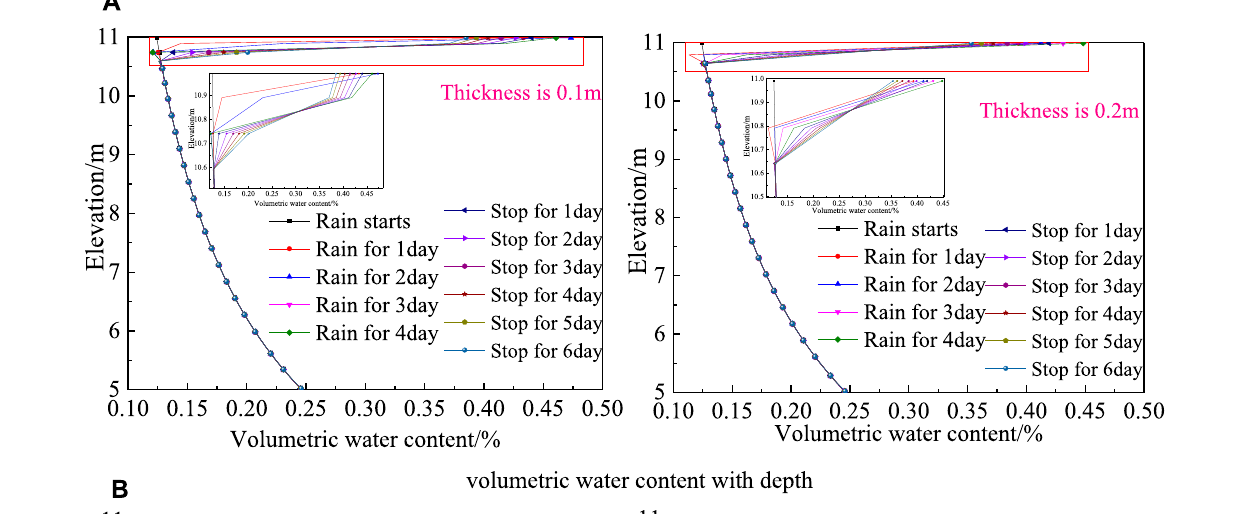
Frontiers in Earth Science |